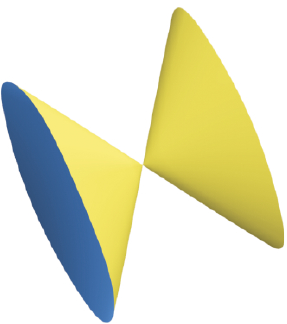
Figure 9. The variety of 3 bar slider crank mechanism in the neigh- borhood of a singular